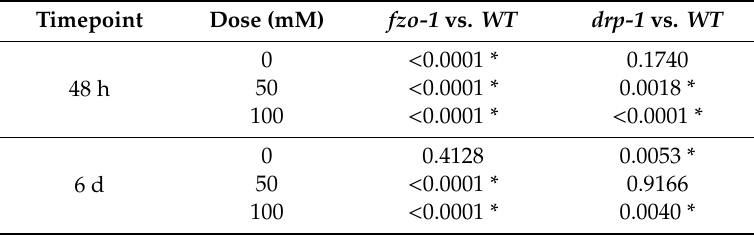
Table 2. p -values (Fisher’s exact test) for strain comparisons ( drp-1 and fzo-1 vs. WT) after 6-OHDA exposure in L4 C. elegans .